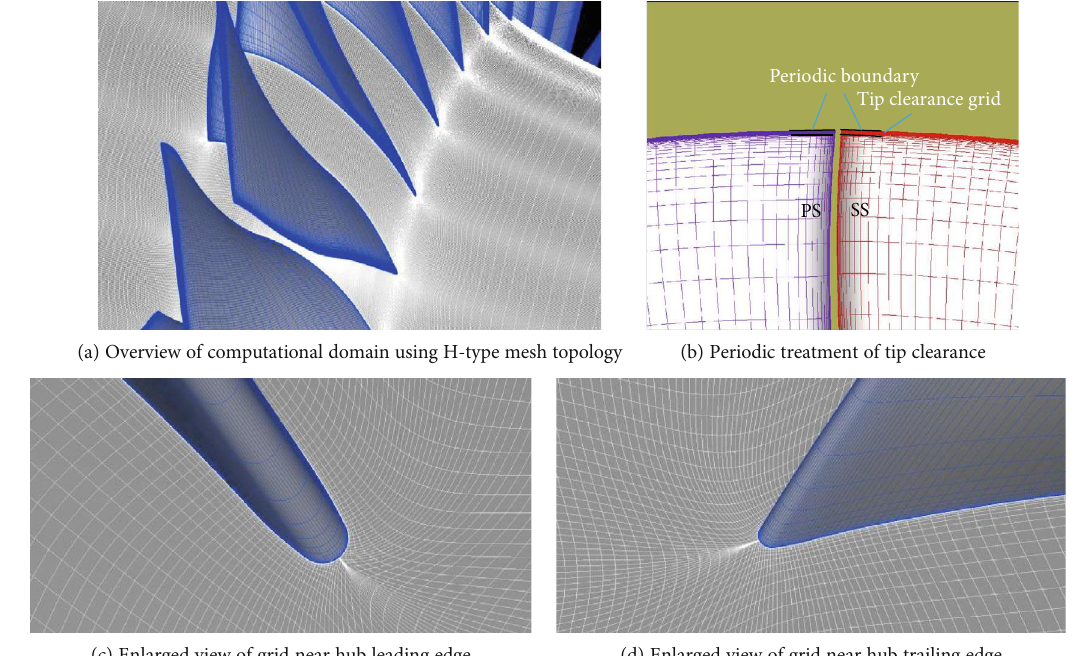
Figure 3: Computational grid of NASA Rotor 67.